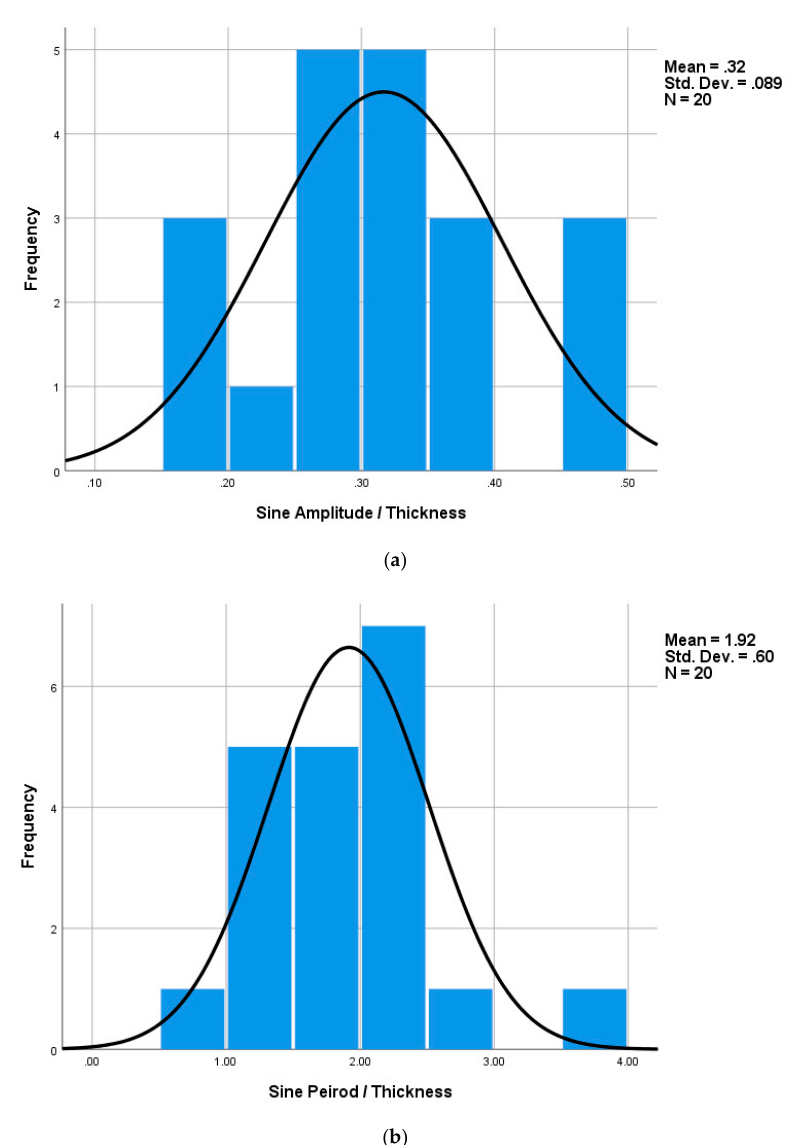
Figure 9. Additional statistical characteristics of microchannels in the form of a sine curve. ( a ) Sine amplitude/thickness; ( b ) Sine